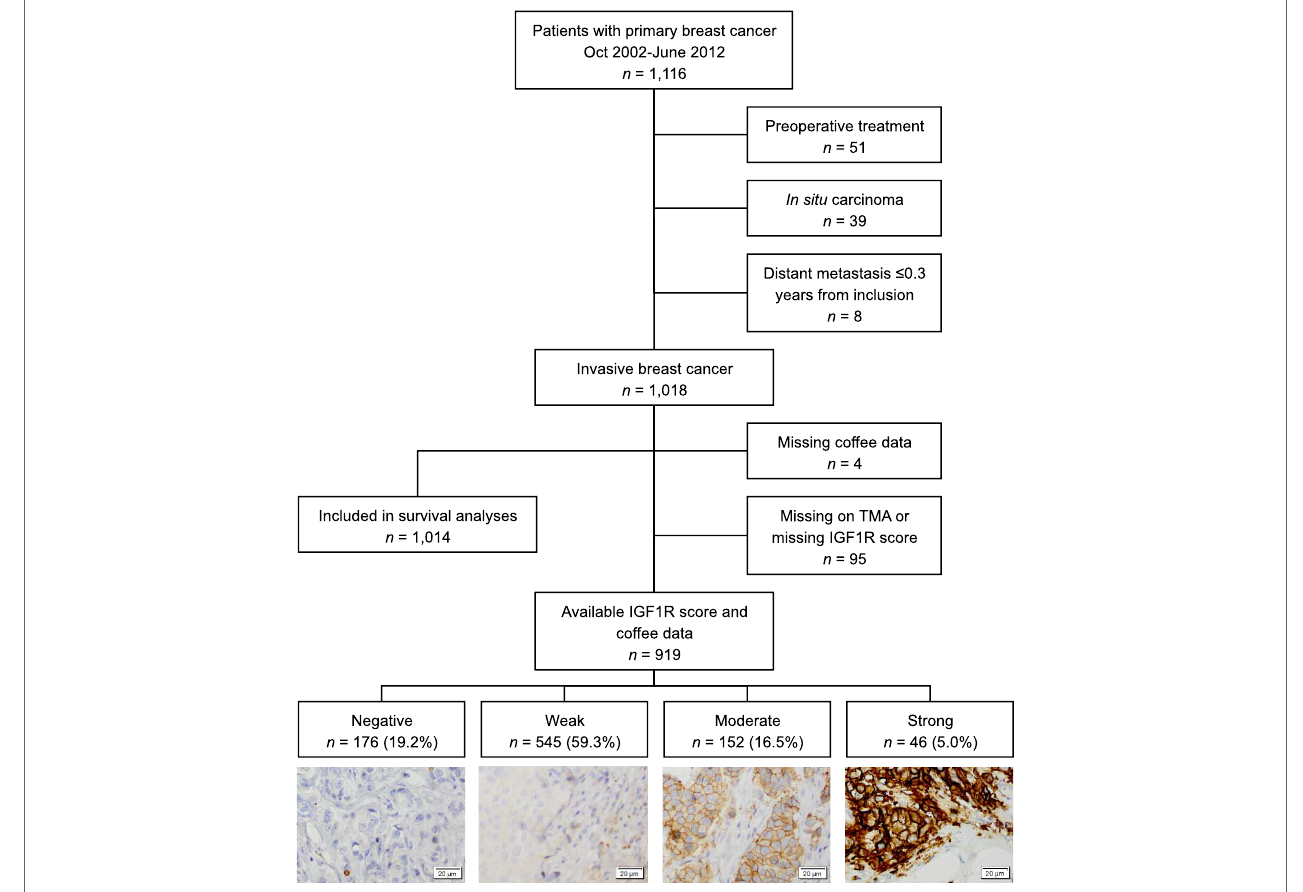
FigUre 1 | Flowchart of included and excluded patients and different levels of insulin-like growth factor receptor 1 staining